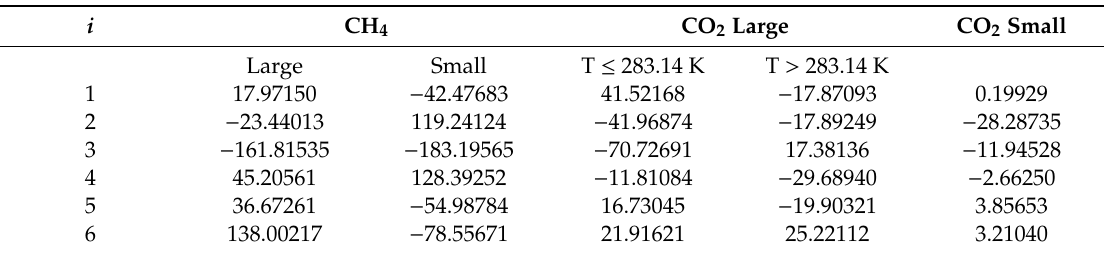
Table 3. Coe ffi cients a i for free energy of guest type j inclusion in cavity type k ; ∆ g kj = = 190.56 K and T with T C CH 4